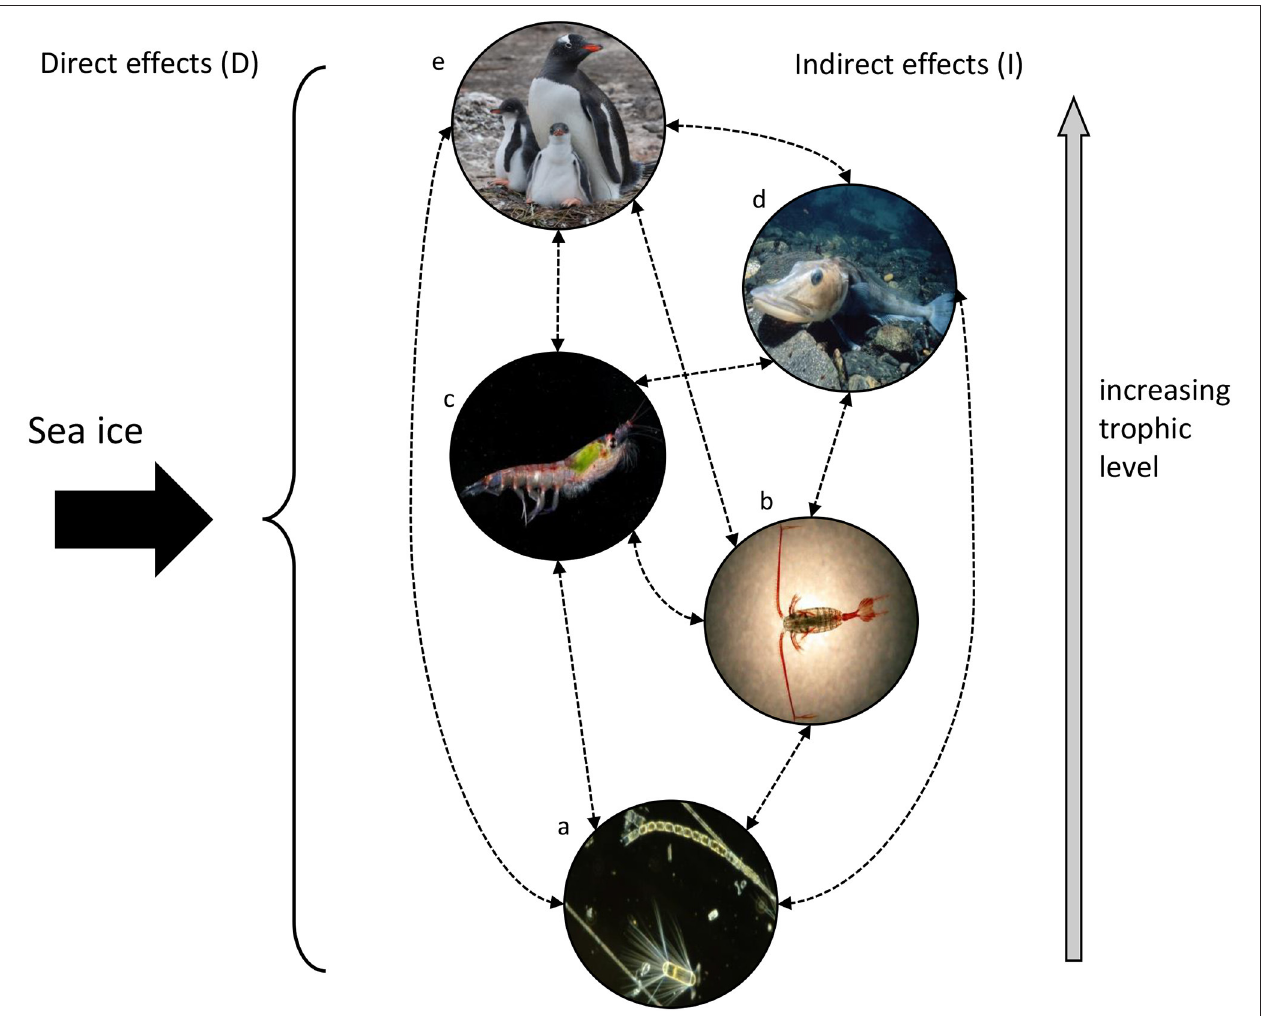
FIGURE 5 | A simplified representation of a Southern Ocean pelagic food web, where the trophic levels are represented by phytoplankton (a), small zooplankton (copepods) (b), large zooplankton (krill) (c), fish (d), and air-breathing predators (seals, whales, penguins) (e). Sea ice exerts direct (D) (black arrow) and indirect (I) (dotted lines) effects at each trophic